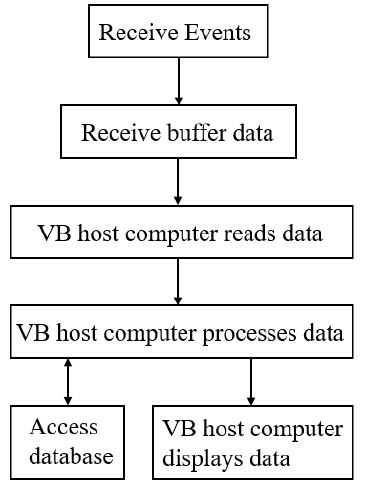
Figure 8. Program framework of host computer.